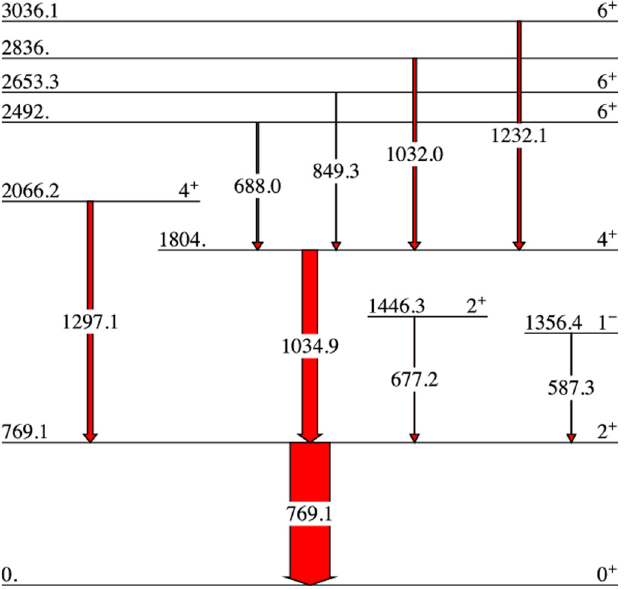
Fig. 5. Partial level scheme and gamma-cascade of 92 Kr analyzed from EXILL experiment measured in coincidence with 142 Ba.